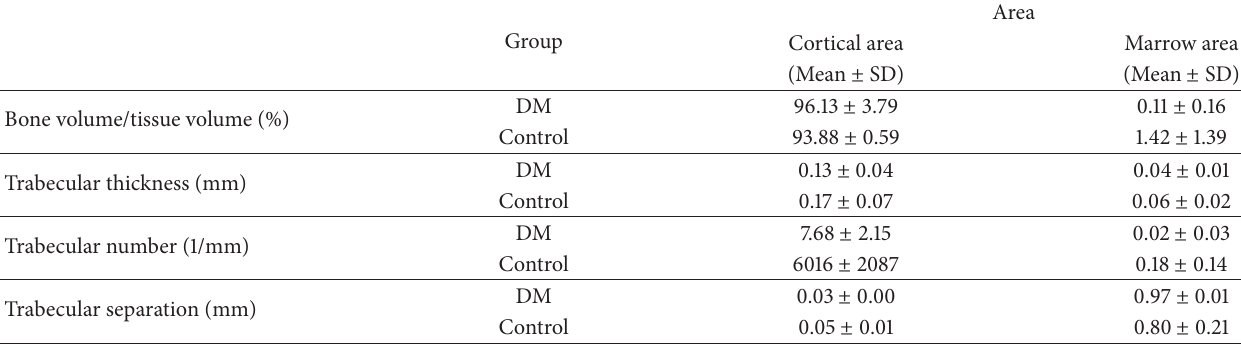
Table 1: Three-dimensional bone microstructure analysis in cortical and bone marrow area.